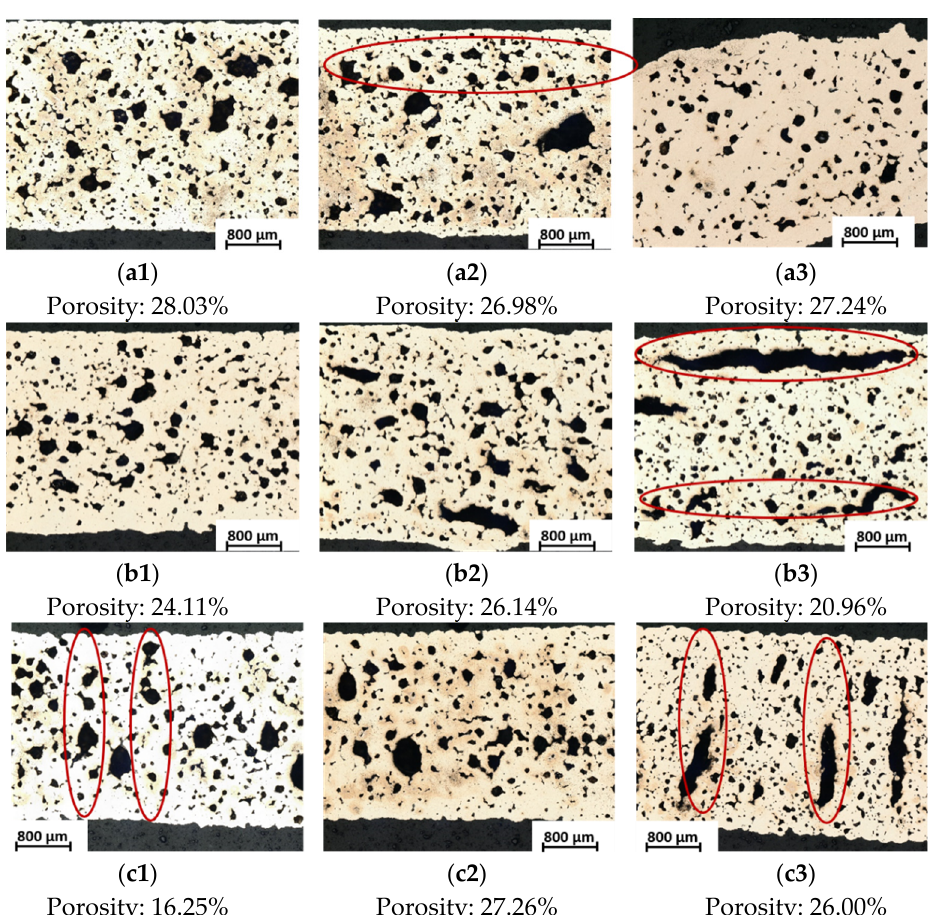
Figure 12. Microstructure and porosity volume fraction of different combination specimens in print- ing and sintering directions (the red circles represented the shapes built from pores): ( a1 ) flat printing–flat sintering; ( a2 ) flat printing–on-edge sintering; ( a3 ) flat printing–upright sintering; ( b1 ) on-edge printing–flat sintering; ( b2 ) on-edge printing–on-edge sintering; ( b3 ) on-edge printing–upright sintering; ( c1 ) upright printing–flat sintering; ( c2 ) upright printing–on-edge sintering; ( c3 ) upright printing–upright sintering.